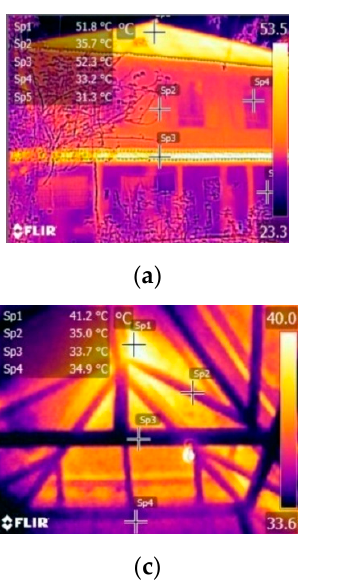
Figure 6. Surface temperature of H-2: ( a ) outdoors, ( b ) first and ( c ) ground floor.